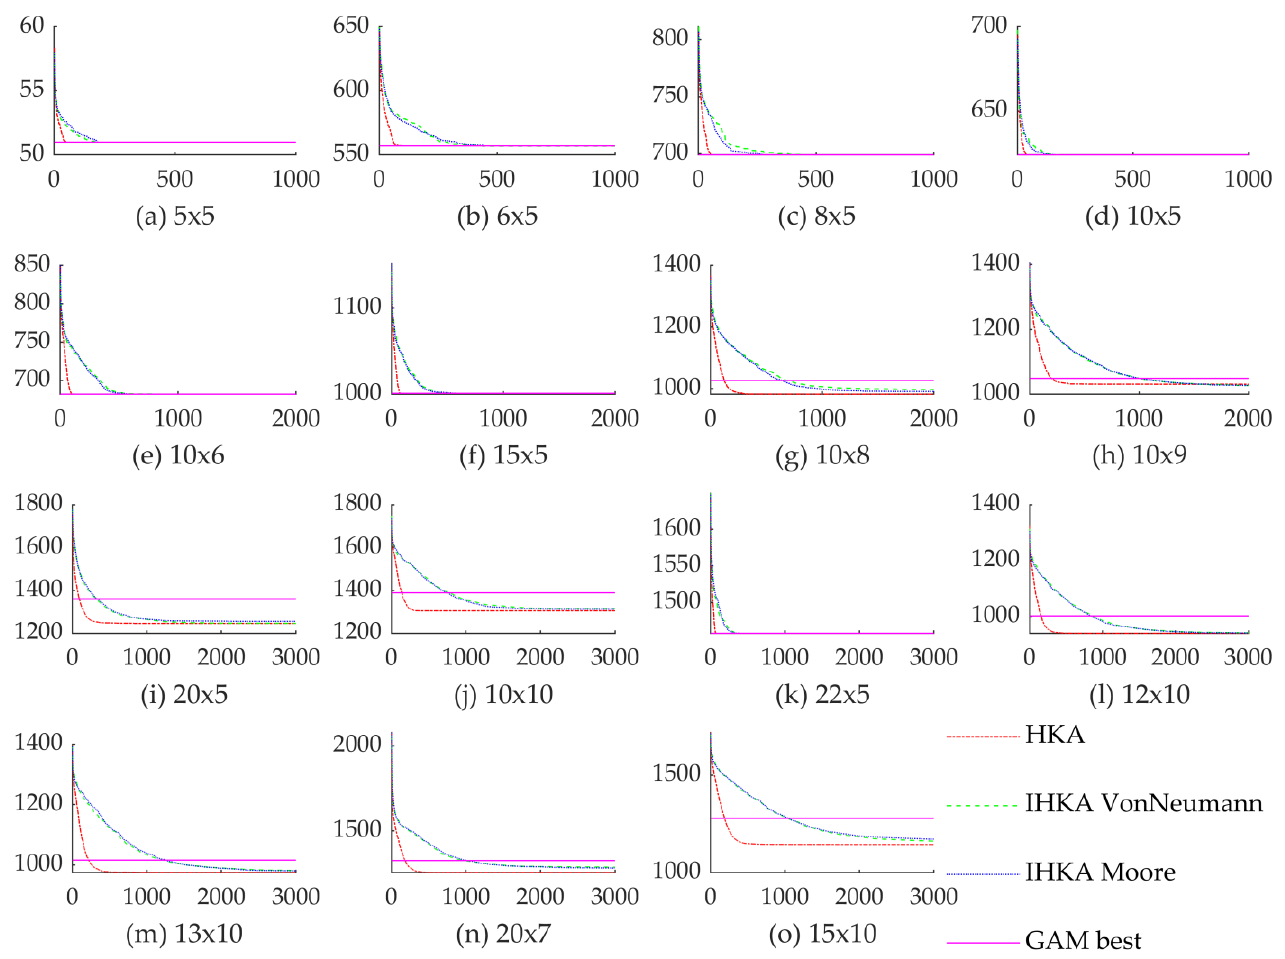
Figure 7. The IHKA and HKA average convergences of the best solutions for the benchmark instances of DJSSP (the horizontal line is the fitness of the best solution obtained by GAM for each instance).